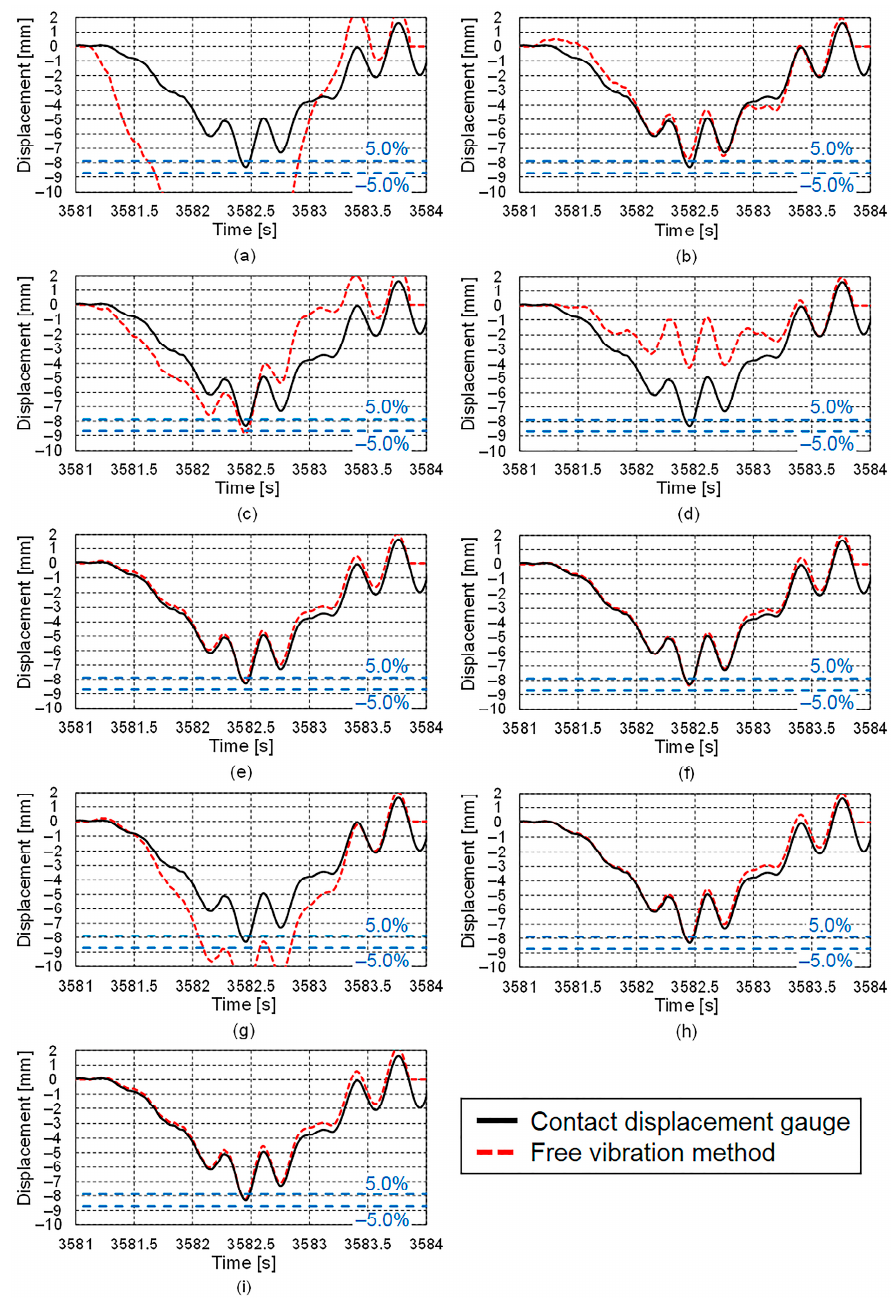
Figure 12. Displacement responses obtained using proposed free vibration separation method: ( a ) Accelerometer A; ( b ) Accelerometer B; ( c ) Accelerometer C; ( d ) Accelerometer D; ( e ) Accelerometer E; ( f ) Accelerometer F; ( g ) Accelerometer G; ( h ) Accelerometer H; ( i ) Servo-type accelerometer.